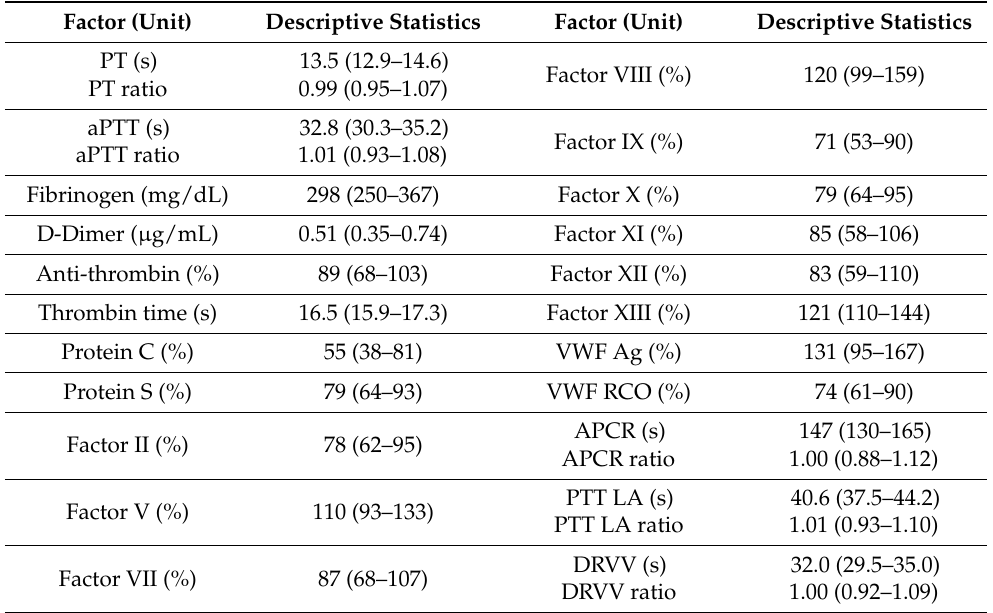
Table 2. Levels of coagulation factors, expressed as the median and interquartile range (IQR) in the whole sample